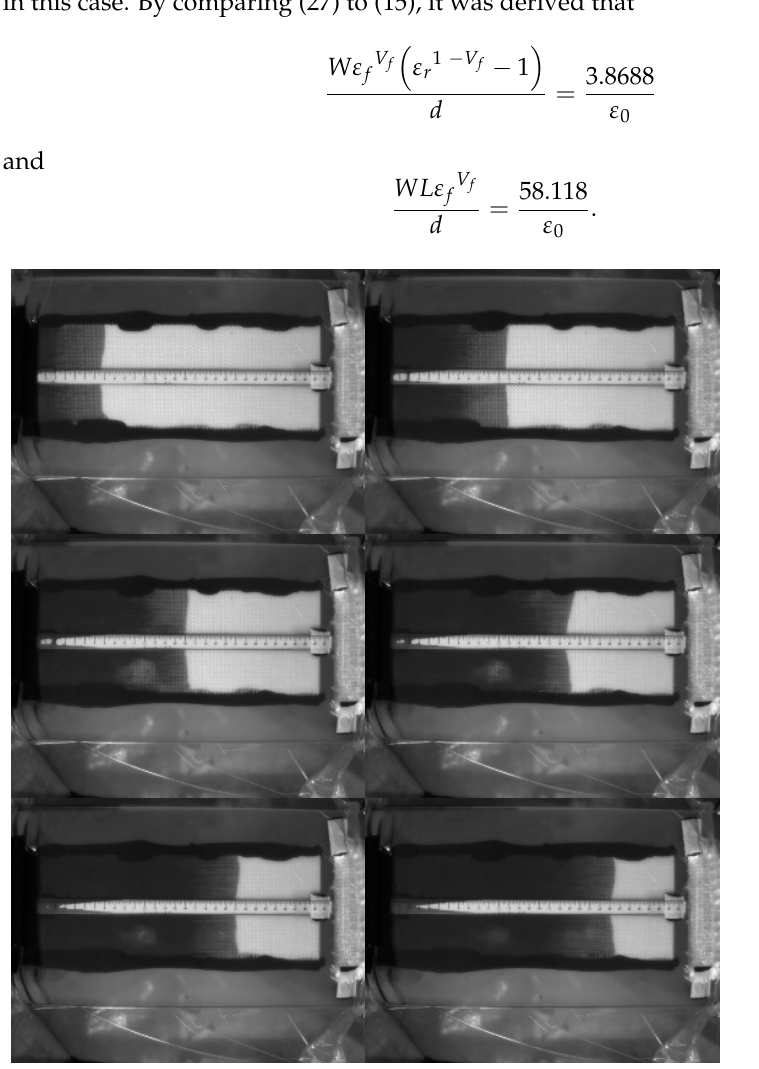
Figure 9. Flow visualization of RTM using a nine-layer fiber preform: images captured at the 50th, 150th, 250th, 350th, 450th, and 550th second.